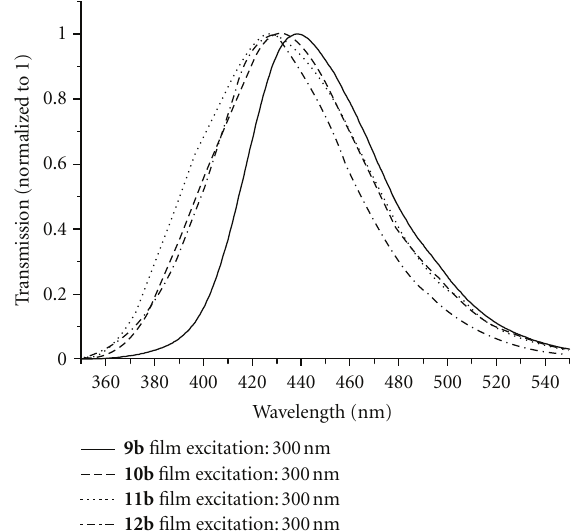
Figure 7: PL spectra of parapolymer films 9b – 12b on silica glass.